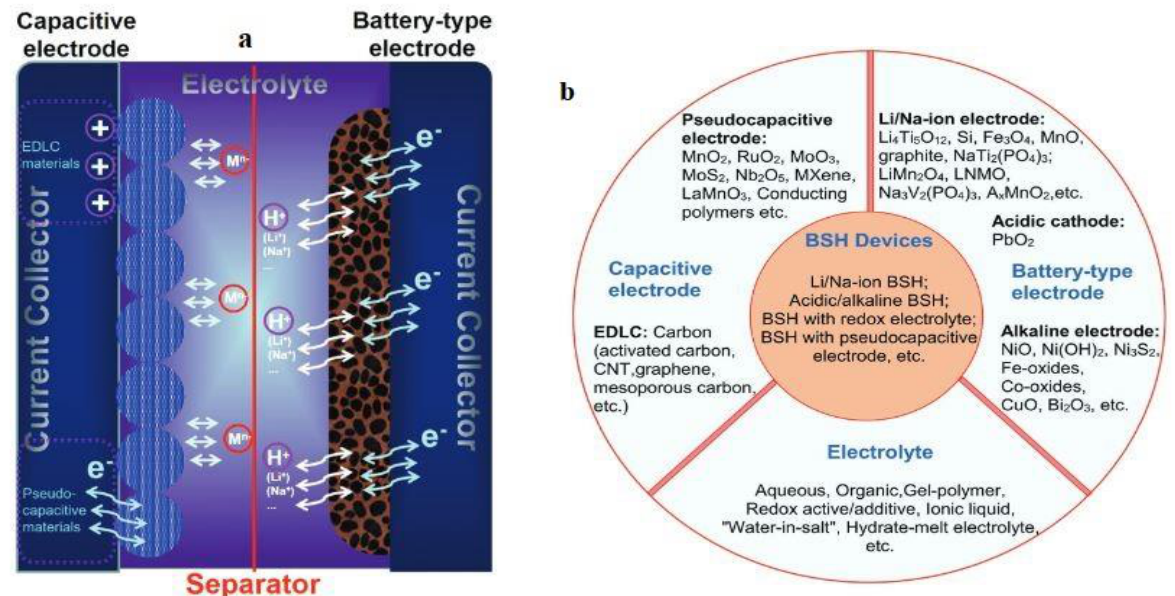
Figure 10. ( a ) A typical hybrid energy storage device with a working process. ( b ) Different types of hybrid devices and their electrolyte and electrode materials. Reprinted with permission from [110].